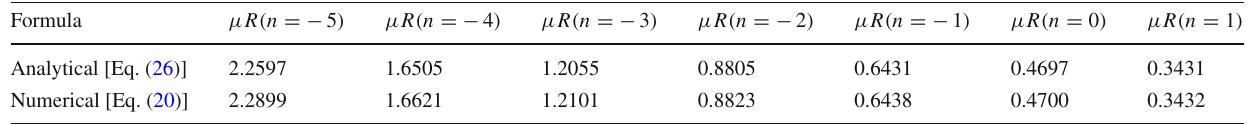
Table 3 Composed charged-reflecting-star-charged-massive-scalar- ing dimensionless radii { μ R numerical s ( n ) } of the spherically symmetric field configurations with α ≡ M μ = 0 . 01 (see footnote 11) and β = 10. We display the discrete resonance spectrum { μ R analytical ( n ) } s 13) between the exact star radii [as computed numerically from the of the dimensionless radii which characterize the spherically symmetric characteristic resonance condition (20)] and the corresponding approx- charged stars with reflecting Dirichlet boundary conditions as obtained imated radii of the spherically symmetric charged reflecting stars [as from the analytically derived resonance formula (26) in the interme- calculated directly from the analytically derived compact formula (26) diate radii regime M (cid:4) R s (cid:4) 1 /μ . We also display the correspond- for the discrete resonance